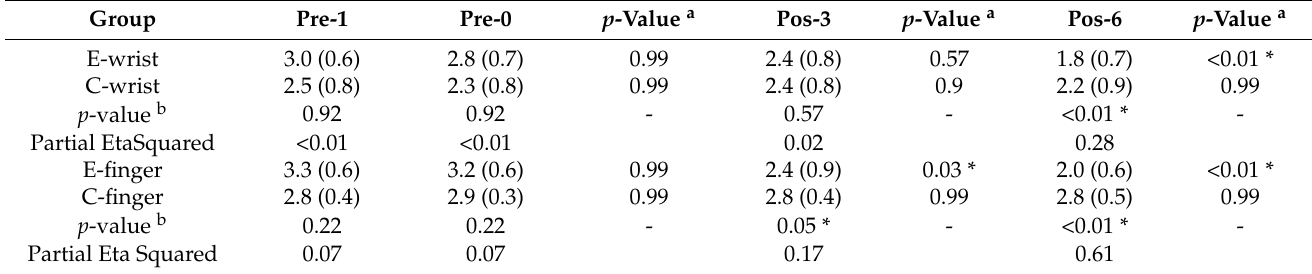
Table 2. Average MAS scores of the wrist and finger flexors in the study groups.